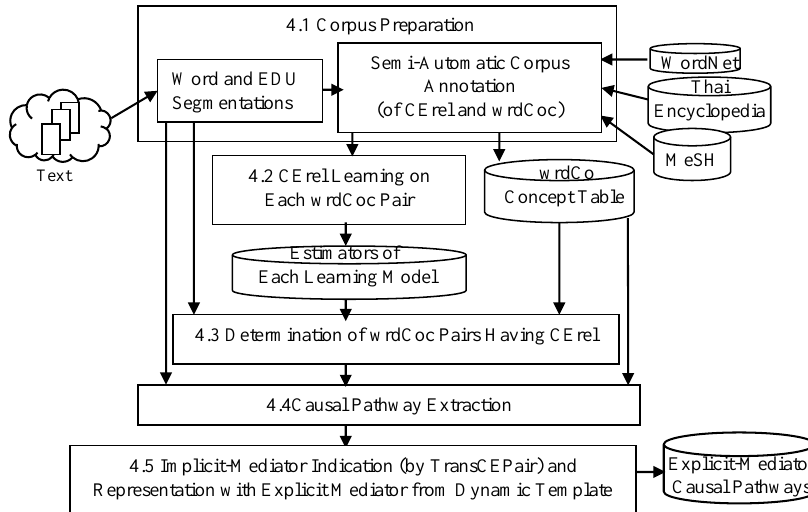
Figure 5. System overview.